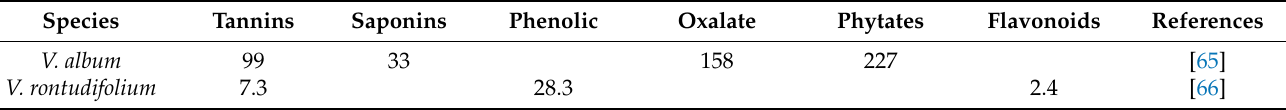
Table 4. Antinutritional factors content (g/kg DM) in Viscum